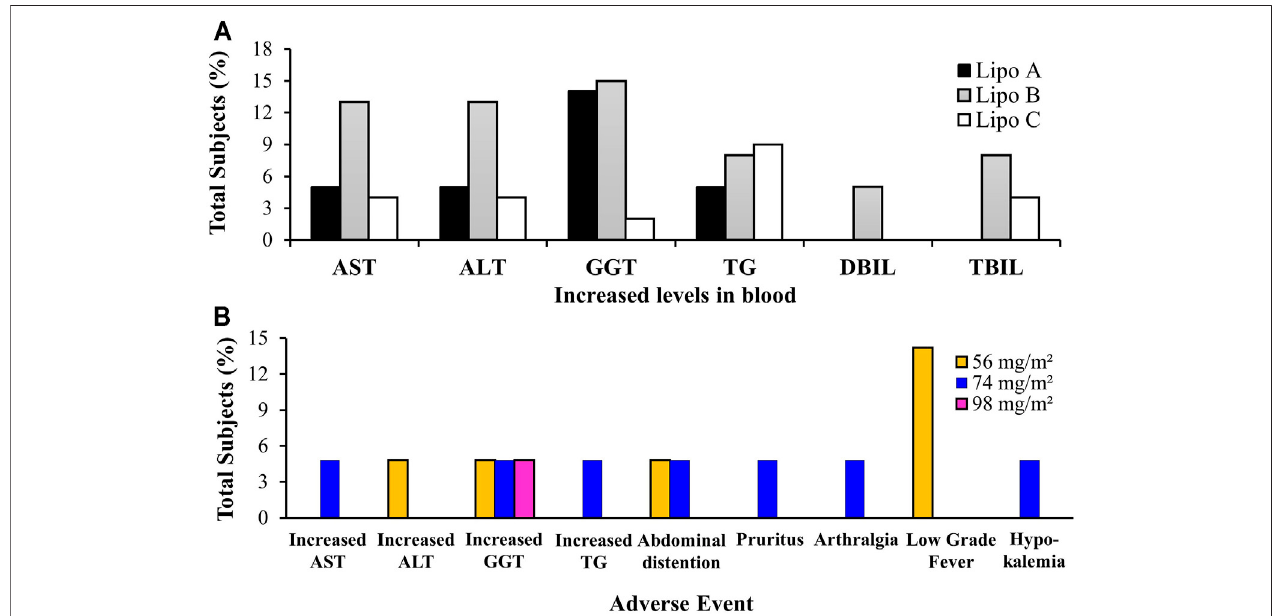
FIGURE6 |(A) Total subjects withincreasing blood marker levels on clinical trials ofLipo A, Lipo B, and Lipo C, (B) Adverseevents of Lipo Aduring phase I clinical trials. Notes: AST, Alanine Aminotransferase/SGPT (serum glutamic pyruvic transaminase); ALT, Aspartate Aminotransferase/SGOT (serum glutamic oxaloacetic transaminase); GGT, Gamma Glutamyl Transpeptidase; TG, Triglycerides; DBIL, Direct Bilirubin; TBIL, Total Bilirubin.